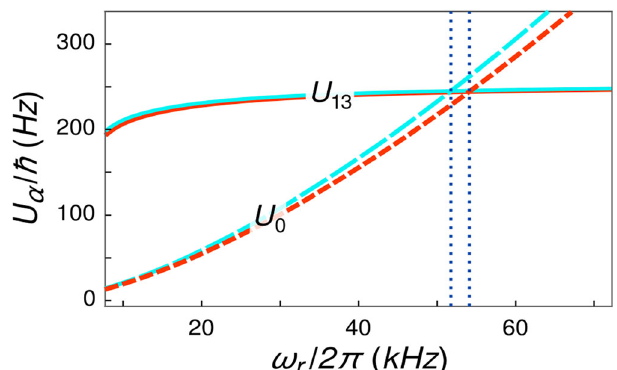
Fig. 3 Ful fi llment of integrability condition. The s-wave scattering length value is set, followed by a variation of the radial trapping frequency ω r up to the point at which U 0 = U 13 , corresponding to the frequency required for the system to be integrable. The red dashed (solid) and cyan long dashed (solid) depict U 0 ( U 13 ) for a = 32.5 a 0 and a = 30 a 0 , respectively, for different values of ω r . By setting a = 32.5 a 0 (30 a 0 ), we fi nd ω ≈ 2 π × 54.110 kHz (51.759 kHz) as the frequency for integrability, which r results in U 0 / ℏ = U 13 / ℏ ≈ 244.405 Hz (245.141 Hz). The points where U = U ω 0 13 and the corresponding frequencies r are highlighted by the dotted lines. The system is robust for small deviations from the integrable point (see Supplementary Note 5 for more